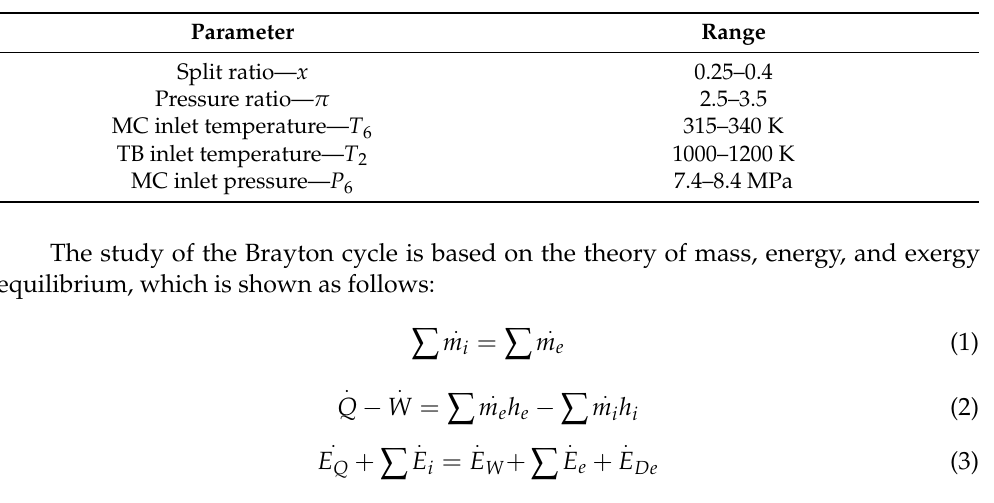
Table 2. Range of the decision operating